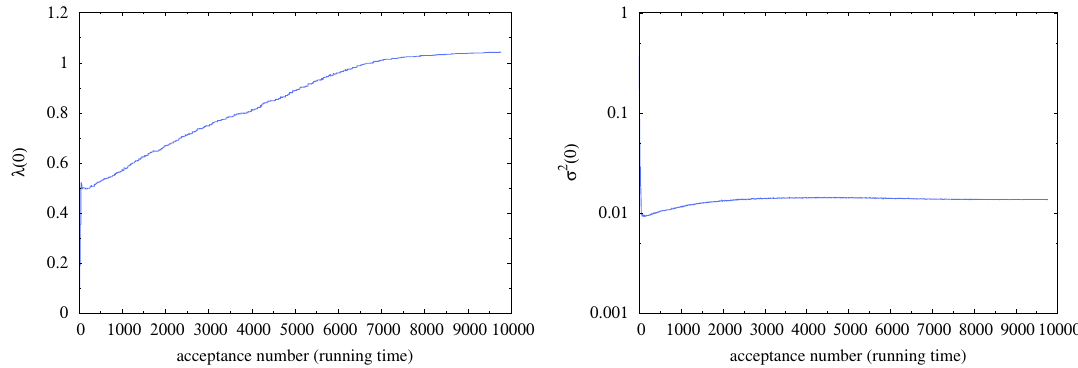
Figure 10 . Later stage of the random walk: the algorithm reduces the numerical error by \pushing out" the corners of (cid:21) and adjusting (cid:21) (0).